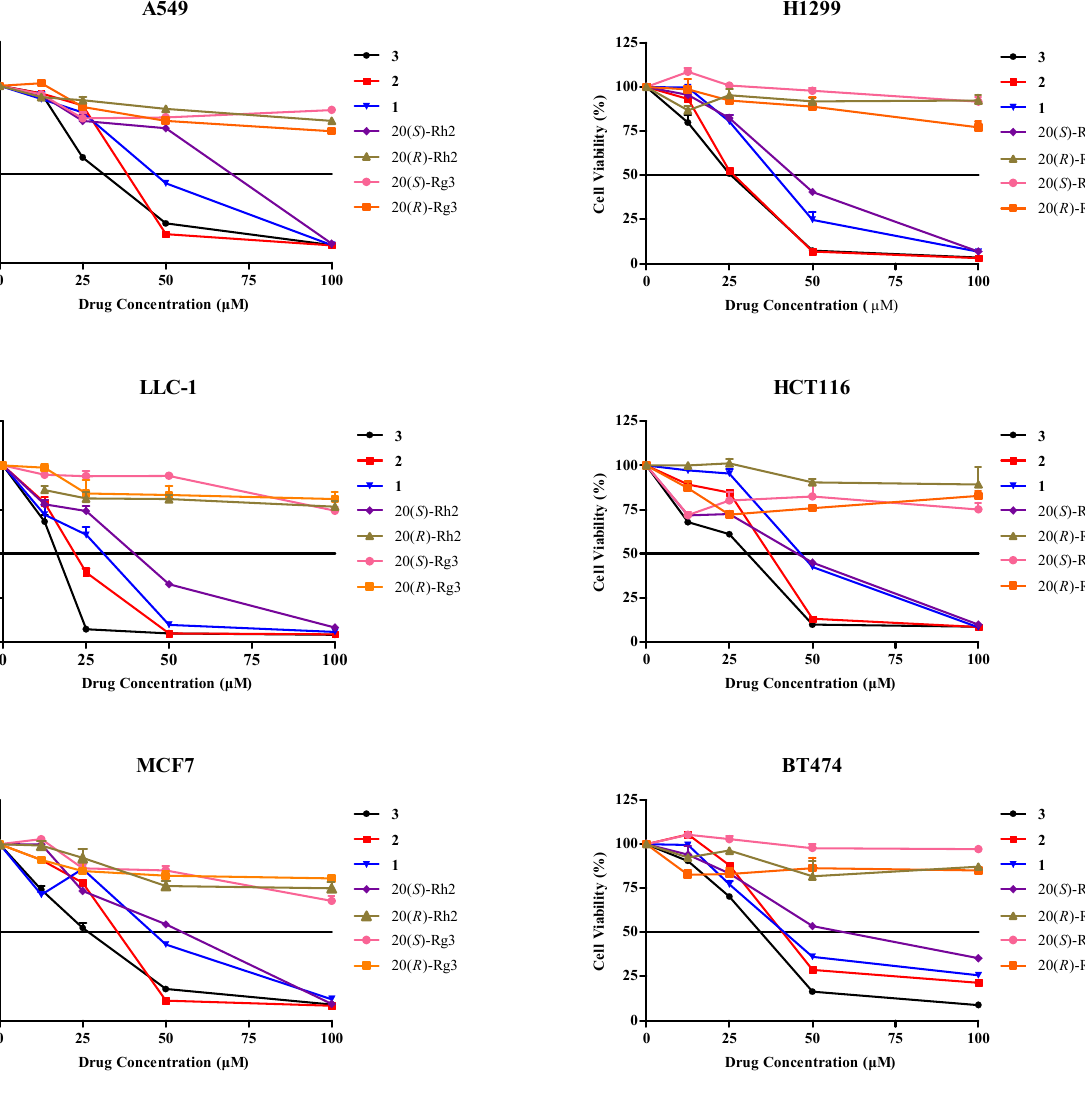
Figure 7. Cytotoxicity of PPD-type ginsenosides and PPD-derivatives against various cancer cell